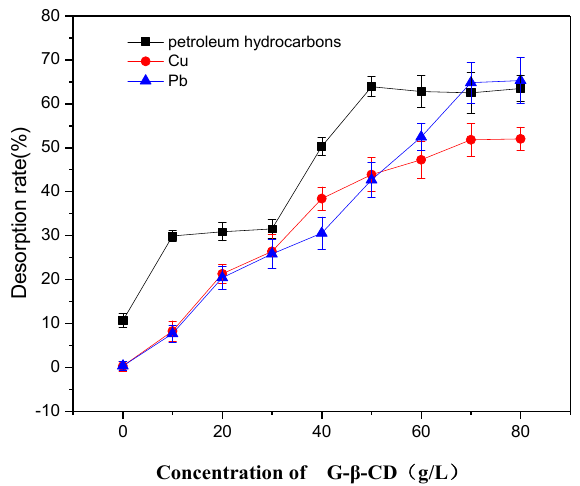
Figure 4. Effect of the initial G- β -CD concentration on desorption.